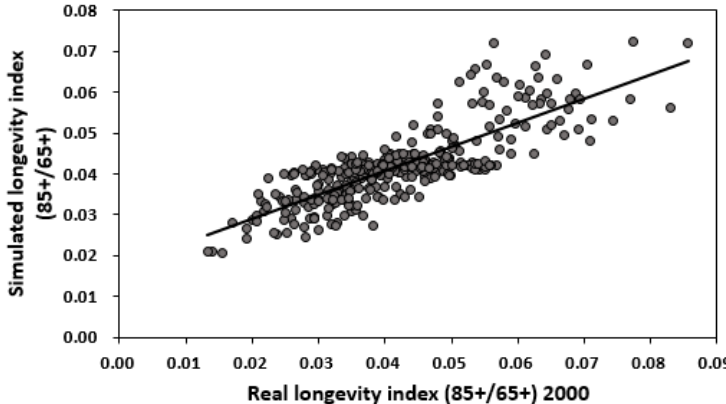
and humidity in 2010.